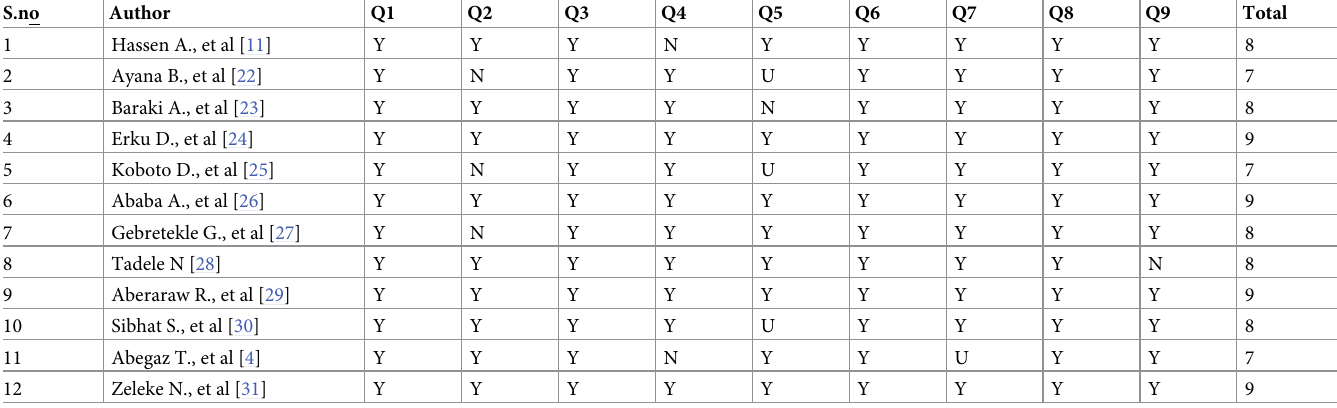
Table 1. Critical appraisal results of eligible studies in the systematic review and meta-analysis on the prevalence of health-related quality of life among cancer patients in Ethiopia,